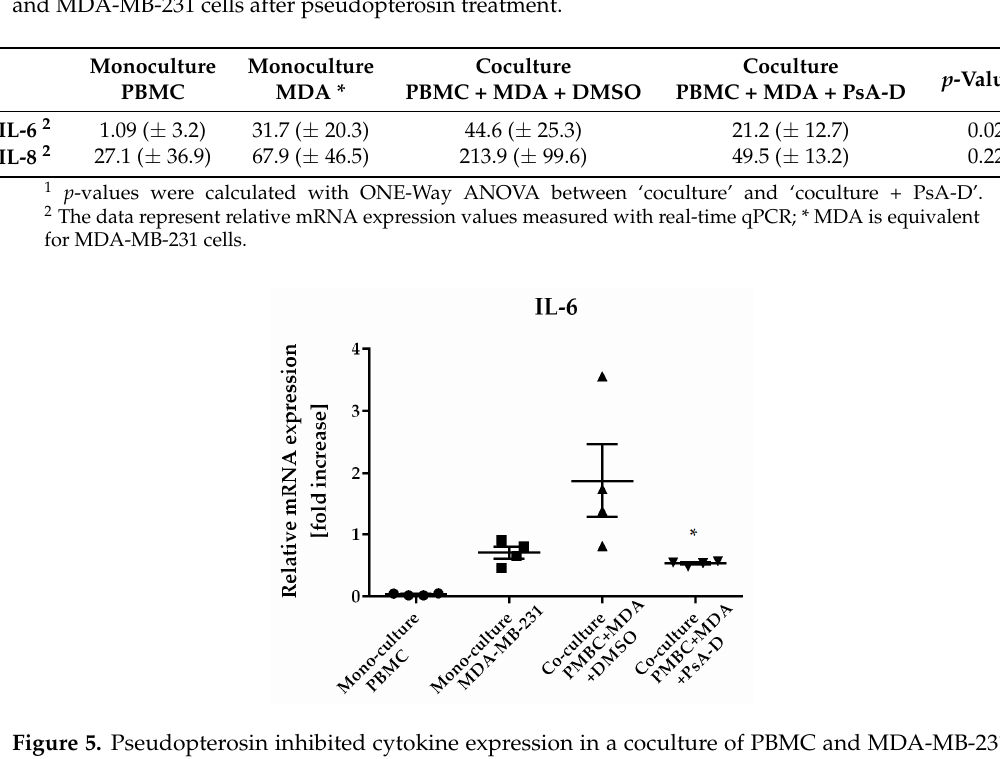
Figure 5. Pseudopterosin inhibited cytokine expression in a coculture of PBMC and MDA-MB-231. Both cell lines were cocultured at a ratio of 1:1 before treatment with 30 µM PsA-D. Cells were harvested 24 h after treatment and cytokine expression levels were analyzed with qPCR. Relative mRNA levels were normalized to fold increase. MDA is equivalent for MDA-MB-231 cells. Data represent means of four independent experiments. Standard deviation was calculated using ±SEM. p -values were calculated between ‘coculture’ and ‘coculture + PsA-D’ using Dunnett’s multiple-comparisons test. One star represents a significance of p <